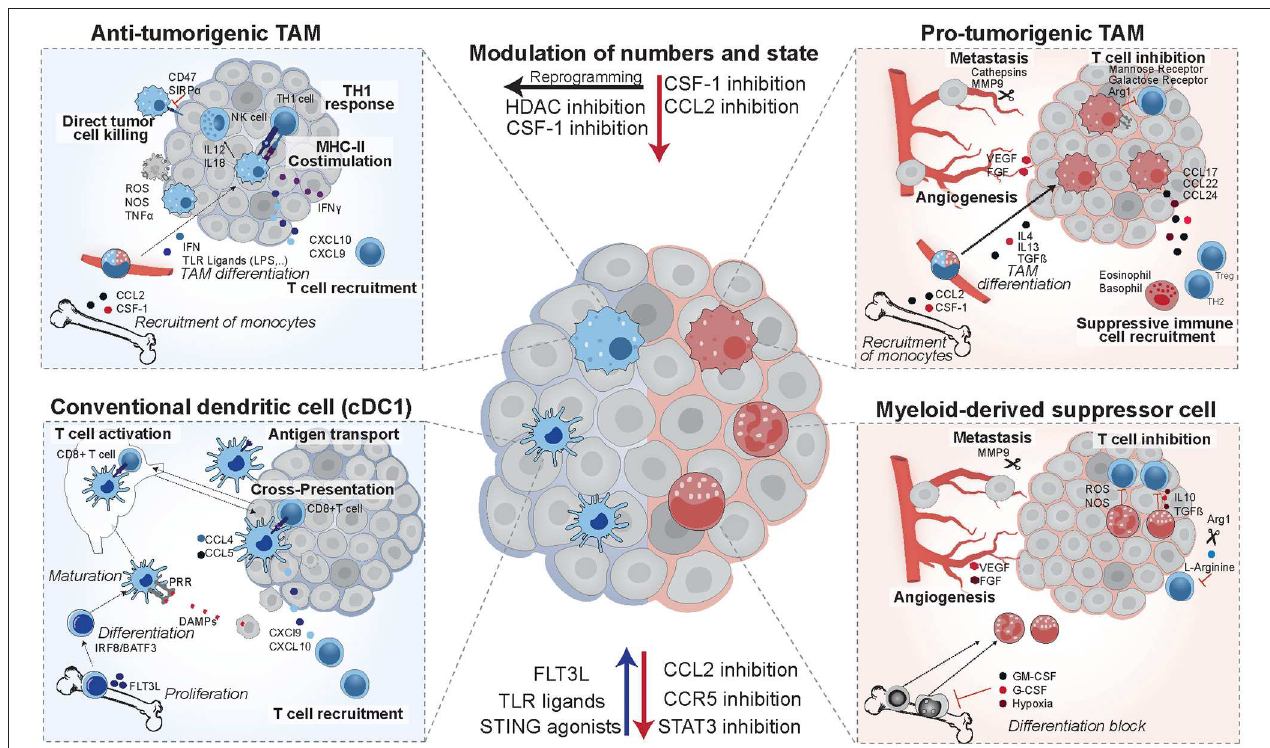
FIGURE 2 | Opposing functions of tumor-infiltrating myeloid cells. Anti-tumorigenic TAMs arise from circulating monocytes in response to TLR ligands and interferon. They are characterized by high expression of costimulatory molecules and MHCII. In mouse models they were shown to induce potent TH1 responses and augment NK cells responses. cDC1 dendritic cells differentiate in response to FLT3L, mature upon recognition of danger associated molecular patterns (DAMPs), and then induce T cell activation via antigen presentation on MHCI. They establish a favorable cytokine environment in the tumor (CXCL9, CXCL10) and murine studies revealed that they are recruited in response to CCL4 and CCL5. In patients, they have positive prognostic value, correlate with T cell infiltration and are enriched in immunotherapy responders. Their numbers and maturation state can be enhanced by FLT3L, TLR ligands, or STING agonists. Pro-tumorigenic TAMs arise from circulating monocytes in response to IL4, IL13, and TGF β , and establish an immune suppressive environment via recruitment of eosinophils, basophils, Tregs, and TH2 cells. They are pro-metastatic and induce angiogenesis, and their recruitment can be reduced by CSF-1 and CCL2 inhibitors in pre-clinical models. In addition, mouse models identified that they can be re-educated to an anti-tumorigenic state using HDAC inhibitors. MDSCs form from immature myeloid progenitors upon stimulation by the tumor and suppress T cell activity via IL10, TGF β , and production of reactive oxygen and nitrogen species (ROS and NOS). They deplete intracellular L-arginine pools and hamper T cell proliferation in murine models and in patients their presence is a negative prognostic